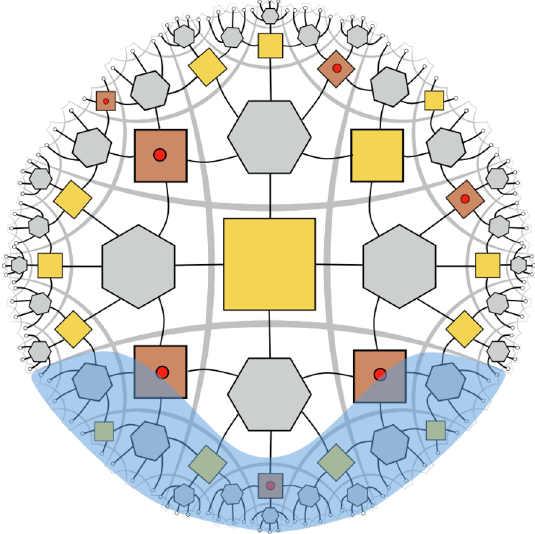
Figure 40. If X tiles are initialized in arbitrary states, then the Greedy wedge cannot move past the perfect tensor. This is true even if the information on these tiles are in | ˜ 1 i and can be recovered. Yellow region is the Greedy wedge if the marked tiles are initialized in